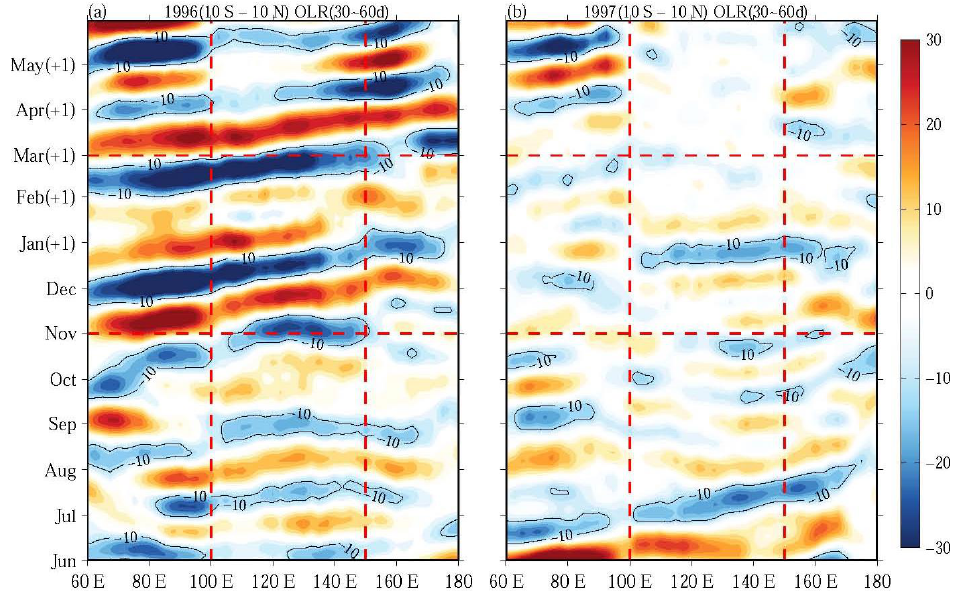
Figure 9. Longitude-time diagram (colors, w · m − 2 ) of the MJO OLR averaged over the 10 ◦ S–10 ◦ N during the ( a ) negative (1996) and ( b ) positive (1997) phases of